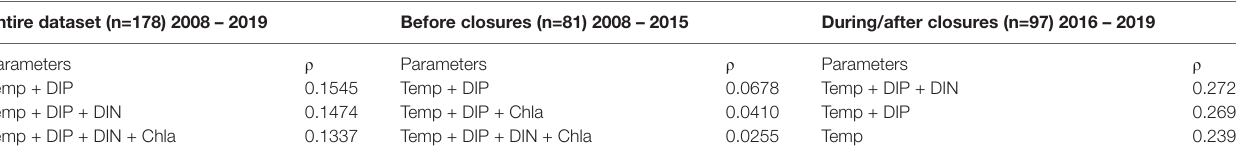
TABLE 1 | BIOENV results of the three models with the highest Spearman rank correlation coefficient ( ρ ) for three timeframes: 2008 – 2019; 2008 – 2015; 2016 – 2019. Entire dataset (n=178) 2008 –